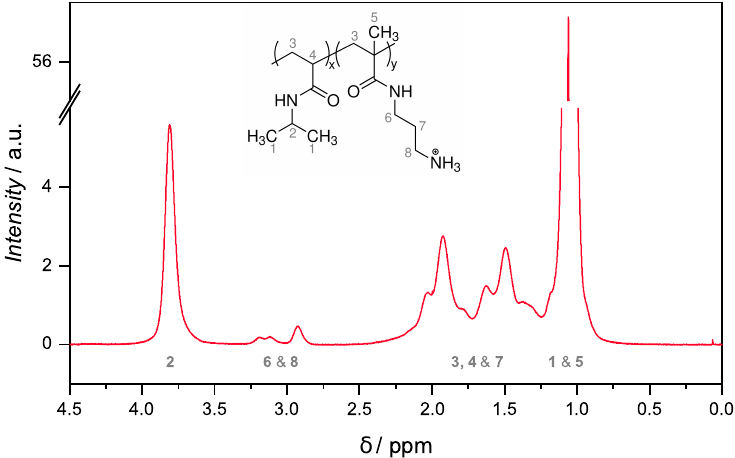
Figure 5. 1 H-NMR spectrum of the APMH-10 microgel in H 2 O/D 2 O. The assignment of signals was done according to [42]. Numbers below the peaks refer to the respective positions in the given structural formula. All other spectra are given in the Supplementary Materials.